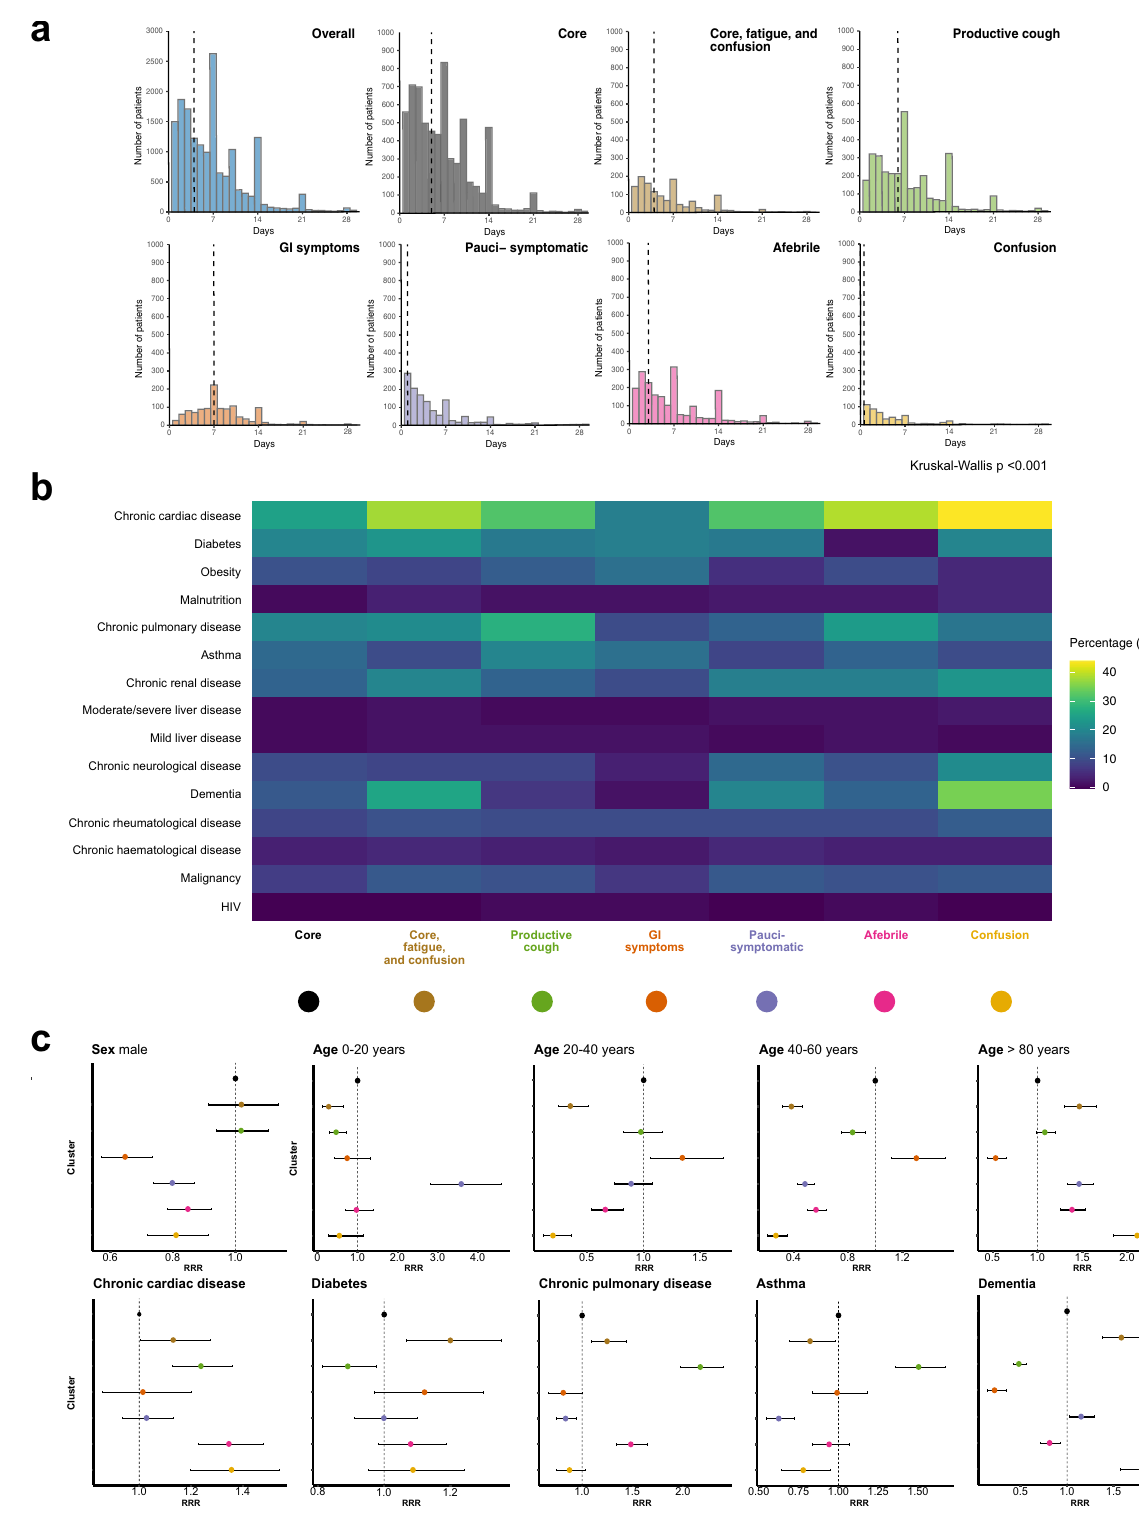
Figure 3. Patient characteristics and symptom clusters. ( a ) Time from symptom onset to hospital admission. Data are presented as counts in singleday bins. Vertical dashed lines represent the median time (days). ( b ) Co-morbidities by symptom cluster. Percentage of individuals with co-morbidity at time of admission. ( c ) Association between patient characteristics and symptom cluster membership. Multinomial regression, presented as relative risk ratio (95% confidence interval). Core symptoms chosen as reference cluster. The age group 60-80 years serves as the reference group for